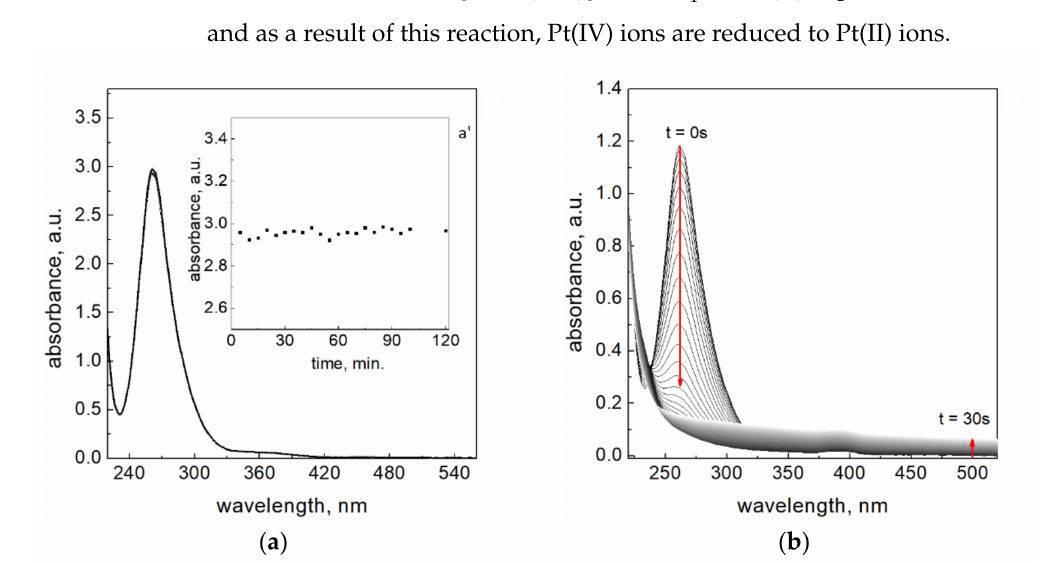
Figure 1. ( a ) Spectrum of aqueous solutions containing 5 · 10 − 4 M Pt(IV) complex ions in 0.05 M NaOH; kinetic curve for Pt(IV) in 0.05 M NaOH registered at 262 nm ( a’ ). Optical path length 2 mm; ( b ) change of absorption bands characteristic for Pt(IV) complex ions during the reaction with NaBH 4 . Conditions: C 0,Pt(IV) = 0.05 mM, C 0,NaBH4 = 3.0 mM, I = 0.05 M,